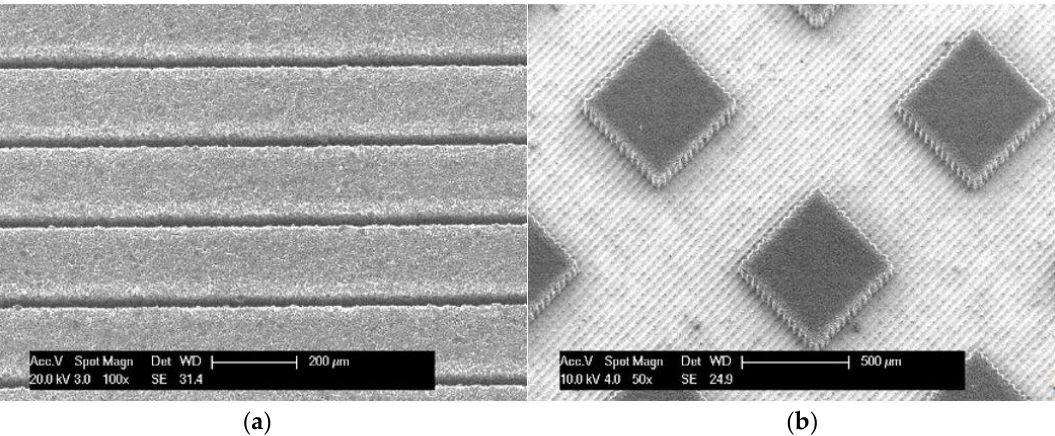
Figure 1. Scanning electron microscopy (SEM) images of laser-generated structures with a period of ( a ) 200 µm and ( b ) micro pillars with a dimension of 600 µm × 600 µm.